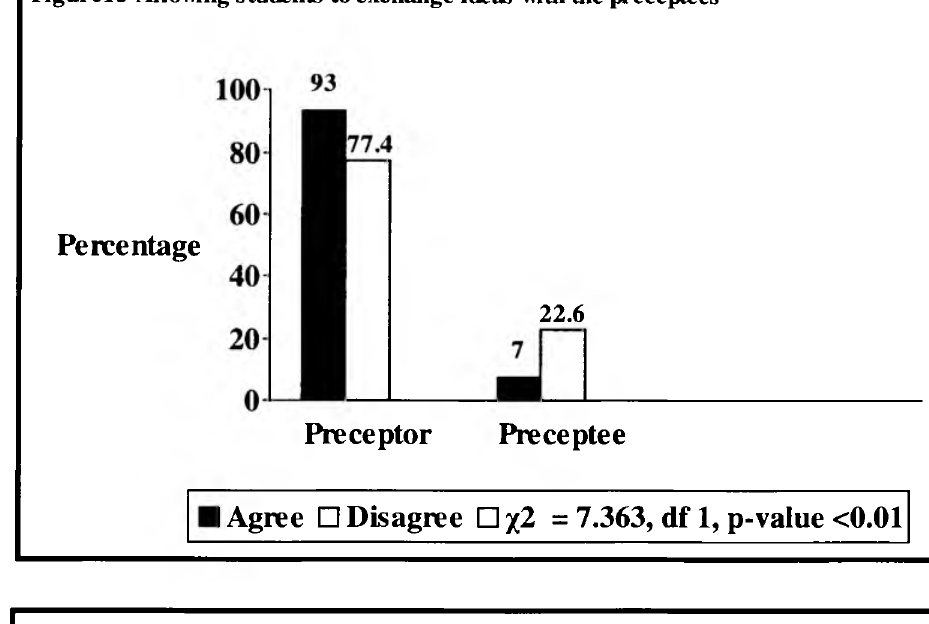
Figurel6 Listening to the students’ problems in the work situation